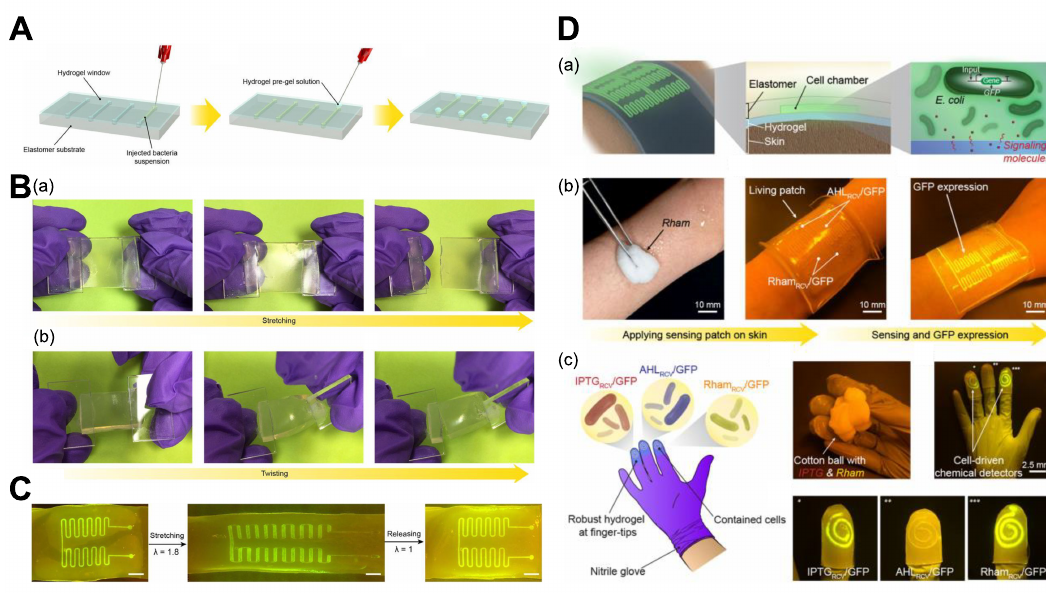
Figure 9. Living materials’ design and devices based on stretchable, robust, and biocompatible hydrogel–elastomer hybrids that host various types of genetically engineered bacterial cells. ( A ) Schematic illustration of cell suspension injection and sealing of injection points; ( B ) deformation of agar-based living devices; ( C ) functional living device under large uniaxial stretch; and ( D ) living hydrogel-based wearable devices. Reproduced with permission from [209]. Copyright 2017, National Academy of